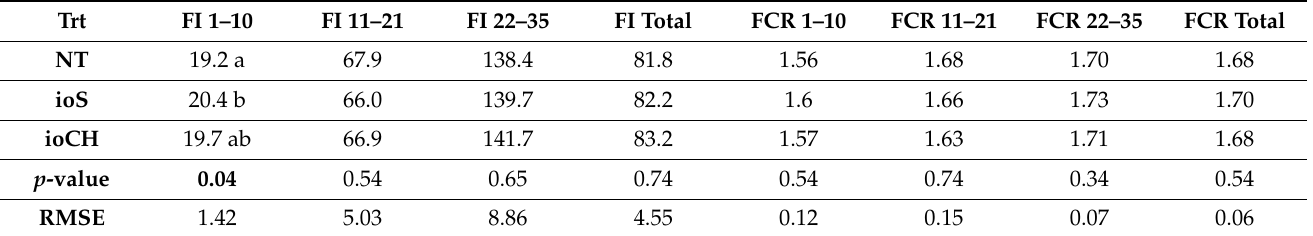
Table 6 summarizes the results of feed intake and feed conversion ratio per pen. Table 6. Feed intake (FI) and feed conversion ratio (FCR) of broiler chicken.